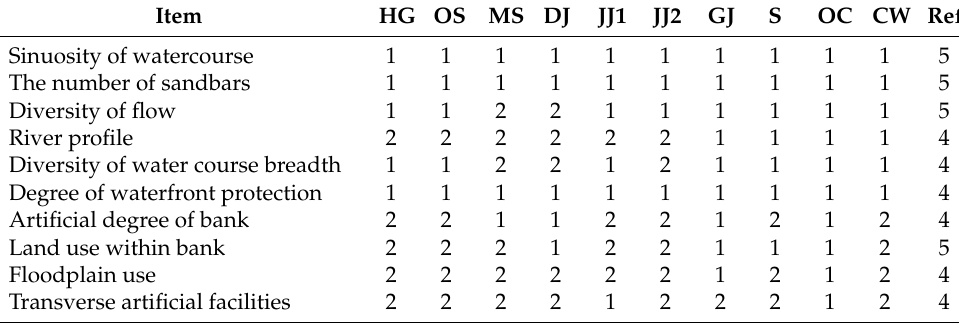
Table 1. The degrees of naturalness assigned to the restored and reference rivers. CW: